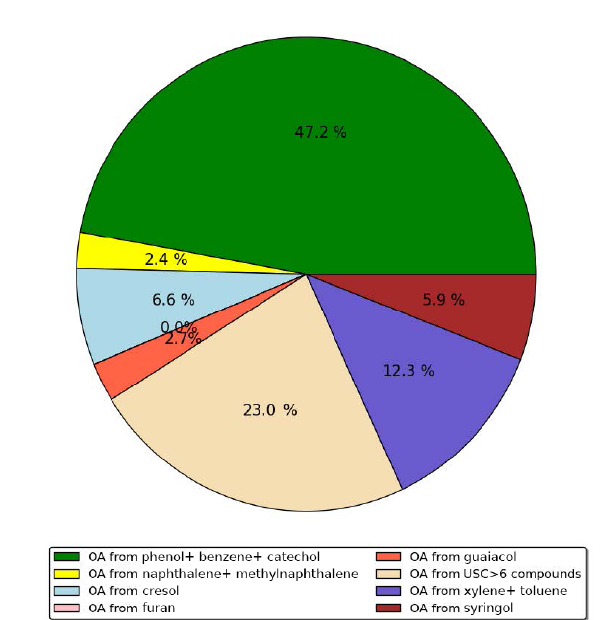
Figure 12. Distribution of the OA concentrations formed from the different VOCs emitted by wildfires over the subregion during the summer of 2007 (simulation